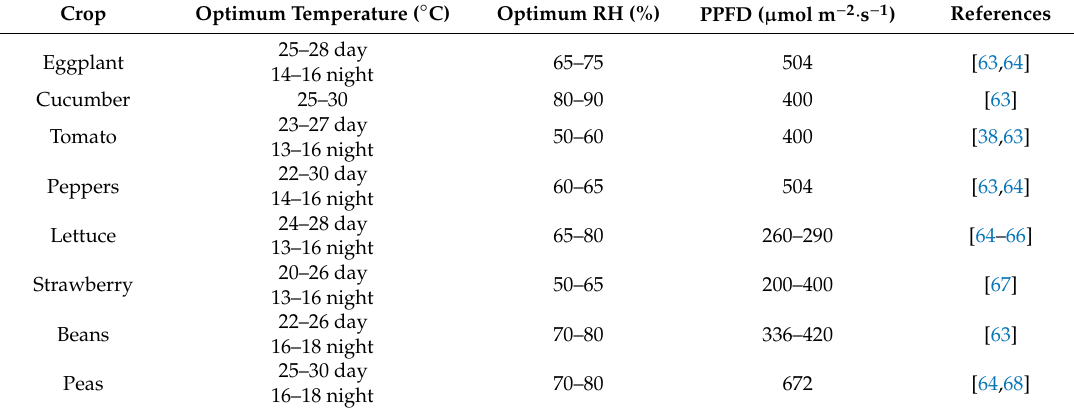
Table 1. Optimum temperature, relative humidity (RH) and photosynthetically active radiation, measured as photosynthetic photon flux density (PPFD), for selected greenhouse crops grown in warm climatic